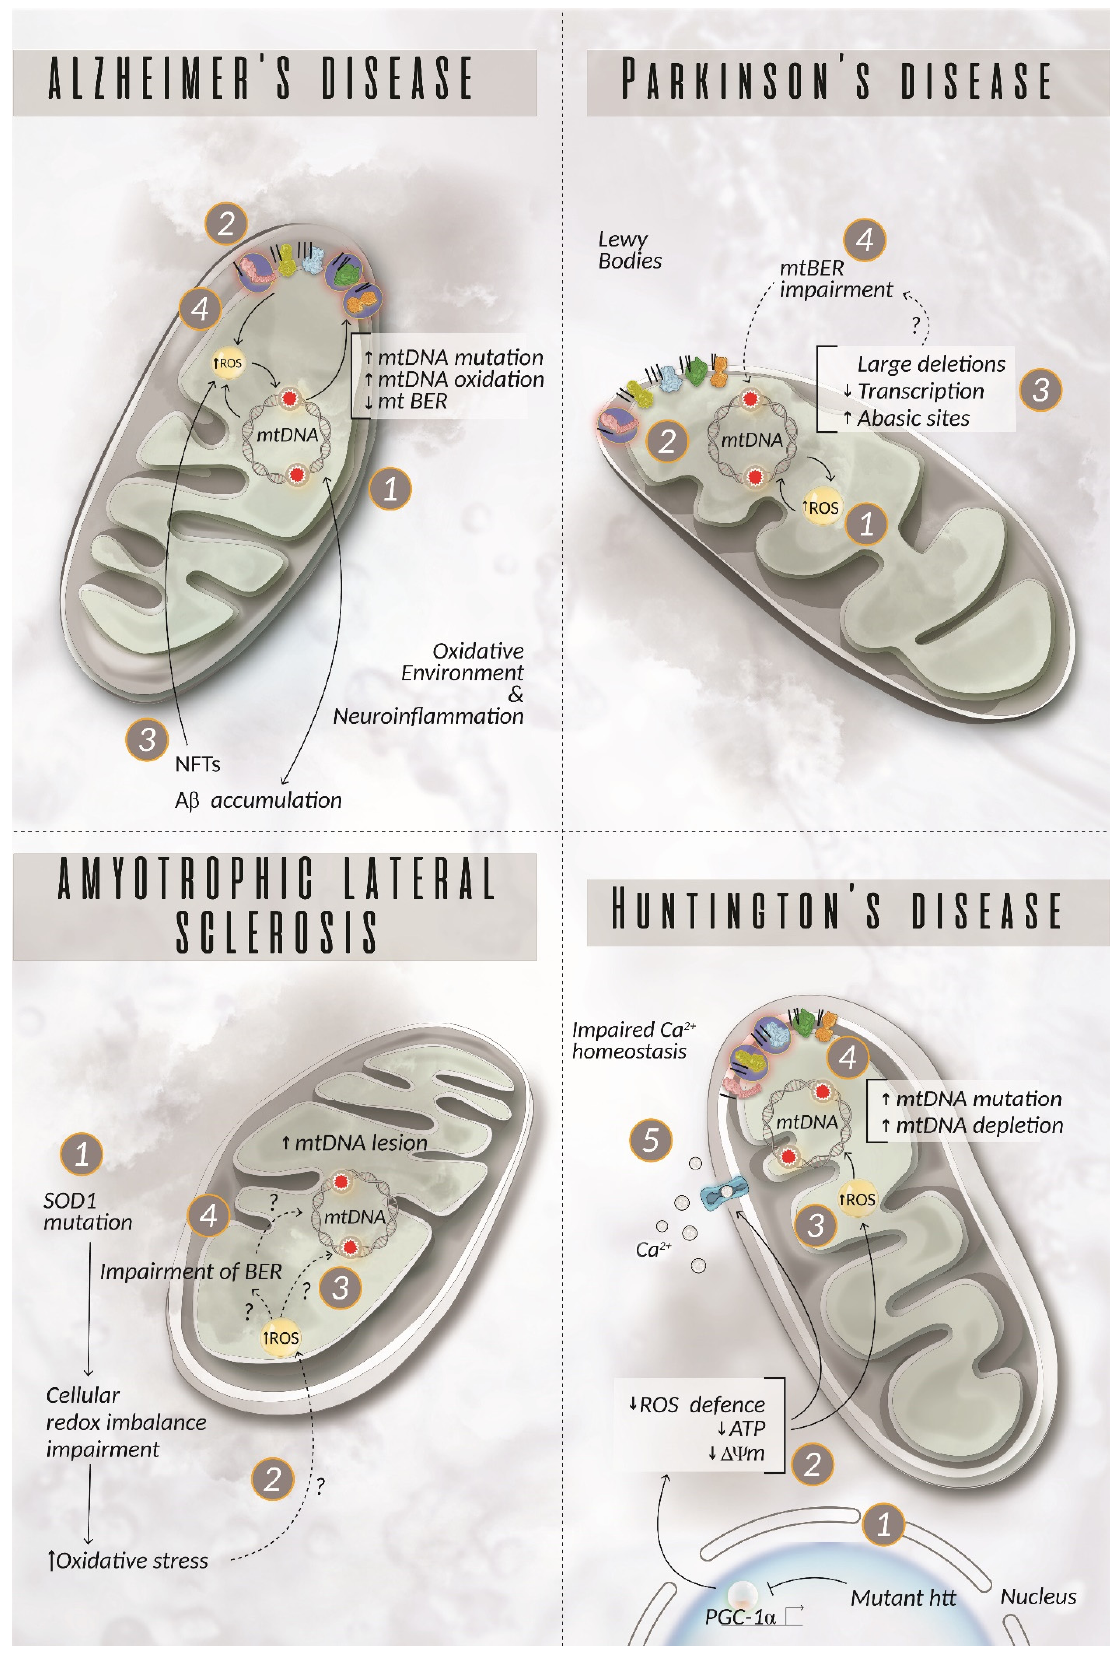
Figure 3. mtDNA damage in neurodegenerative diseases. Alzheimer’s disease (AD). mtDNA damage in AD can lead to energy failure (1) driven by the defective complexes I, III, IV, and V (2),